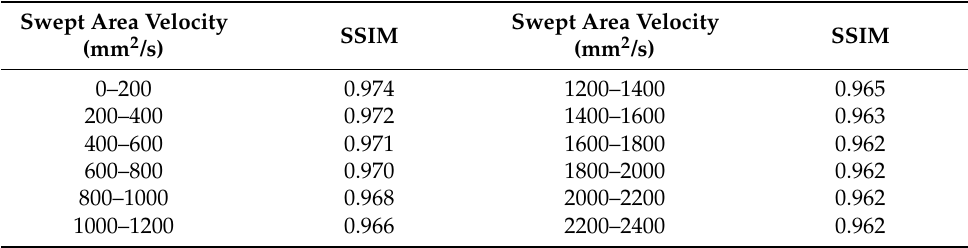
Figure 7. An example of the relationship between velocity and accuracy. ( a ) The opening distance profile of endpoints. ( b ) The swept area velocity profile. ( c ) The SSIM profile. Table 11. The swept area velocity and